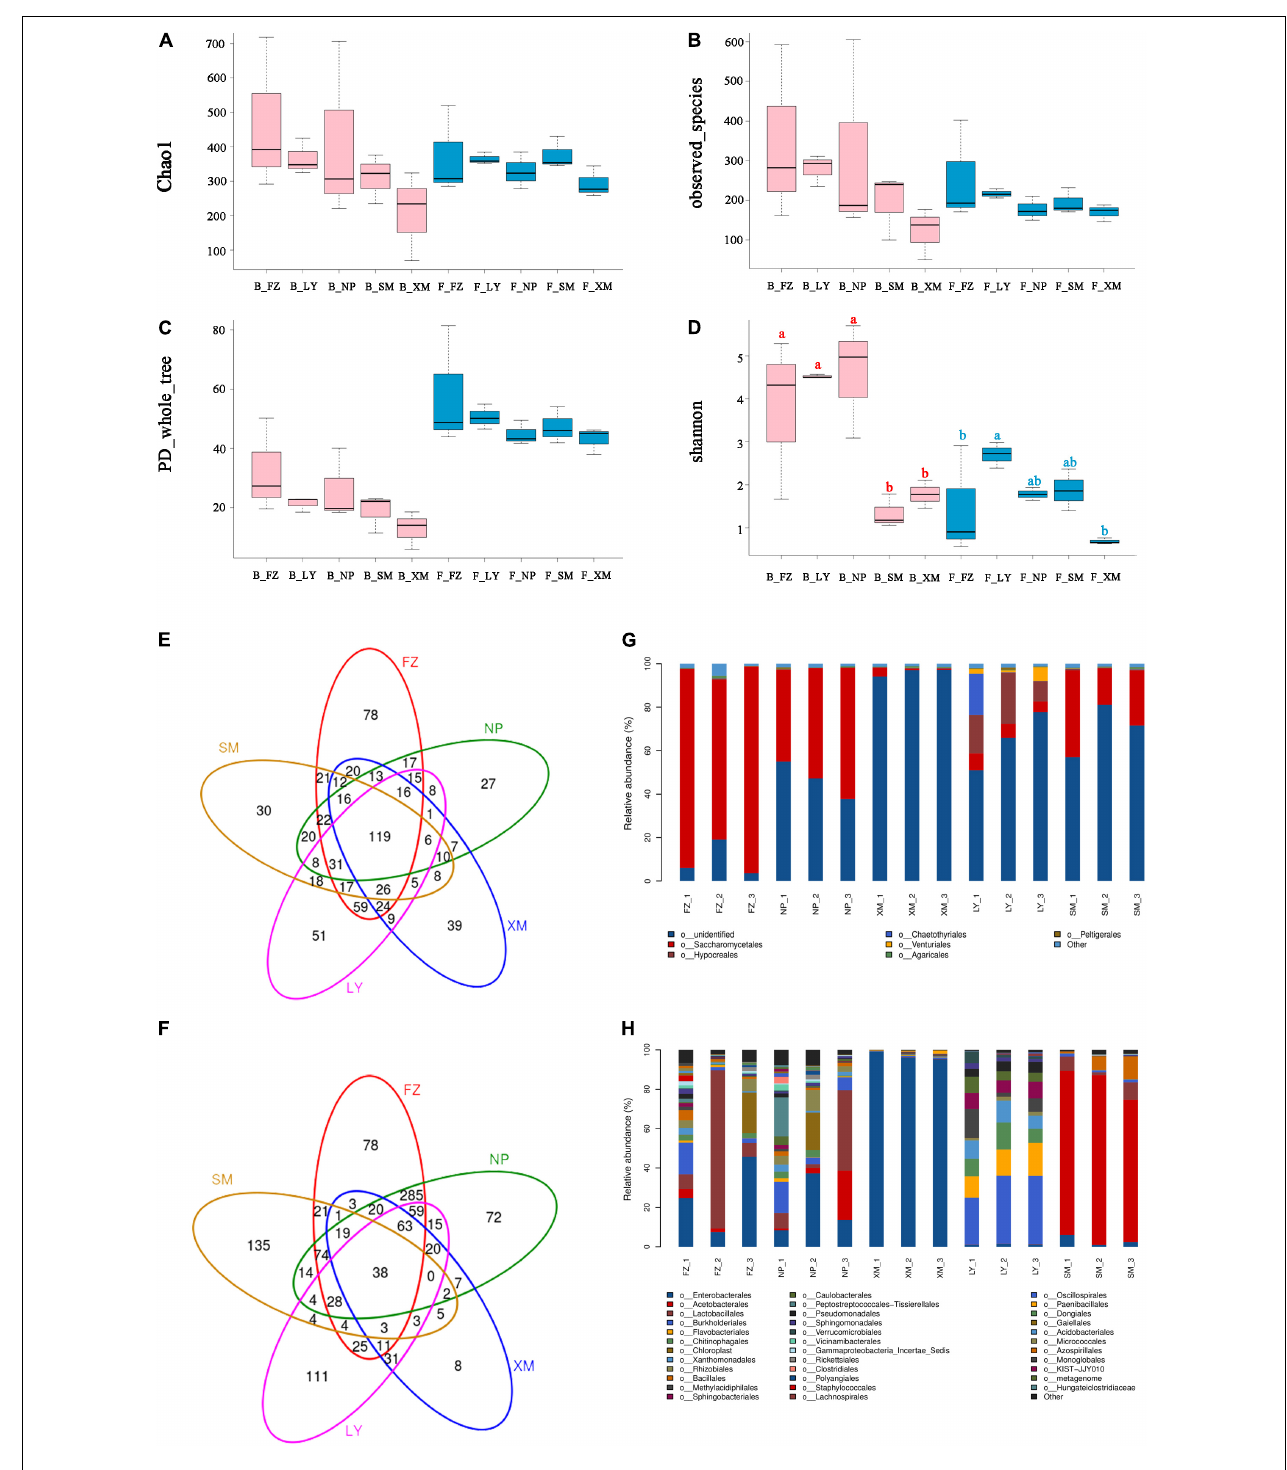
FIGURE 2 | Diversity and construction of associated microbiota in different APMSs. Diversity of associated microbiota in different APMSs were compared and are shown as the following indices: Chao1 (A) , observed species (B) , PD_whole_tree (C) , and Shannon (D) of fungal (F_) and bacterial (B_) community in different AMPSs (SM, FZ, NP, LY, and XM indicate the associated microbes originate from Sanming, Fuzhou, Nanping, Longyan, and Xiamen, respectively). Venn diagram of OTU numbers of fungal (E) and bacterial (F) communities associated with different AMPSs. Construction of fungal (G) and bacterial (H) communities of different samples are presented at the taxonomic level of order. Different low-case letters (red for bacteria, blue for fungi) above the columns represent significant differences ( P < 0.05) based on one-way ANOVA, with multiple comparison analysis using Tukey’s test.